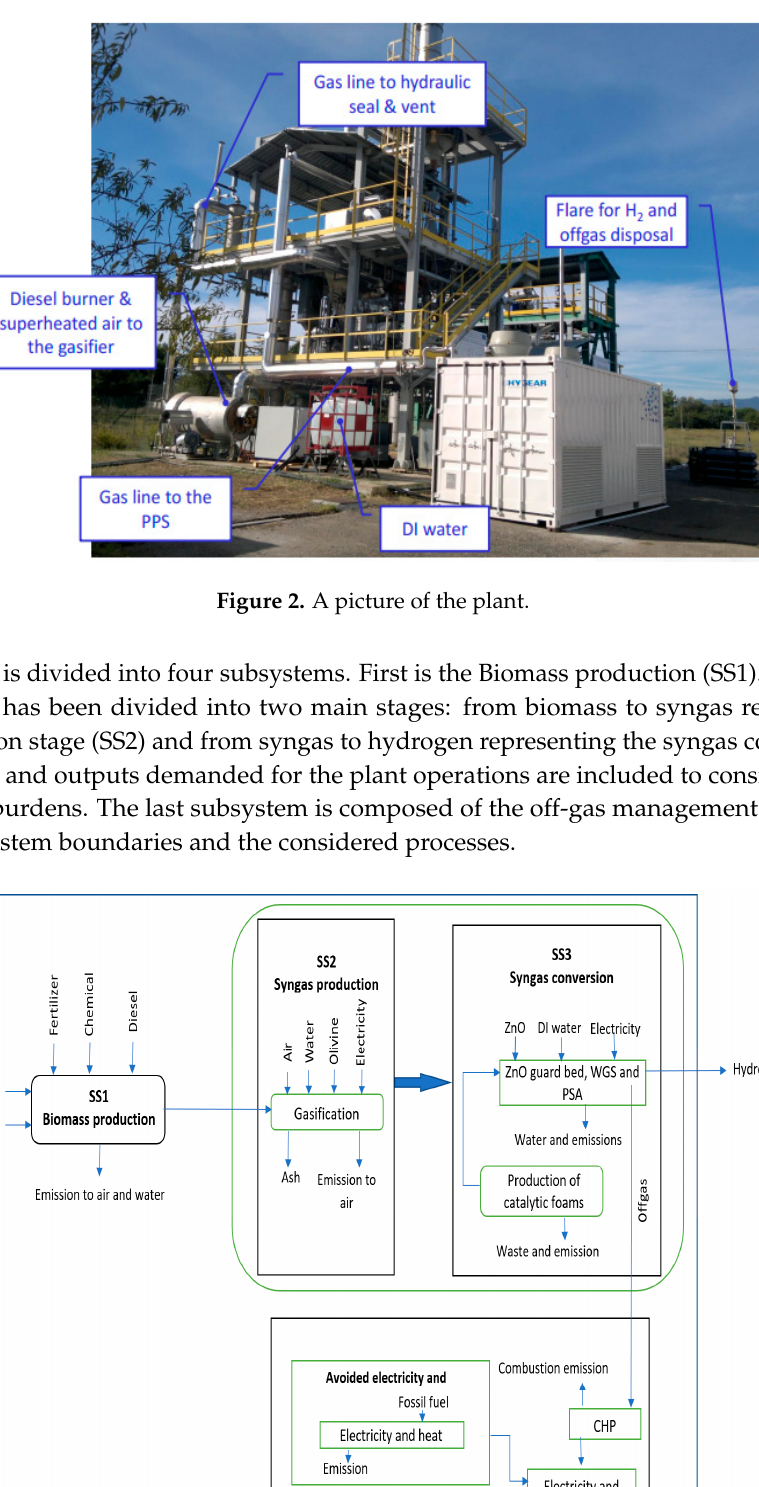
Figure 3. Life cycle boundaries for hydrogen production system.